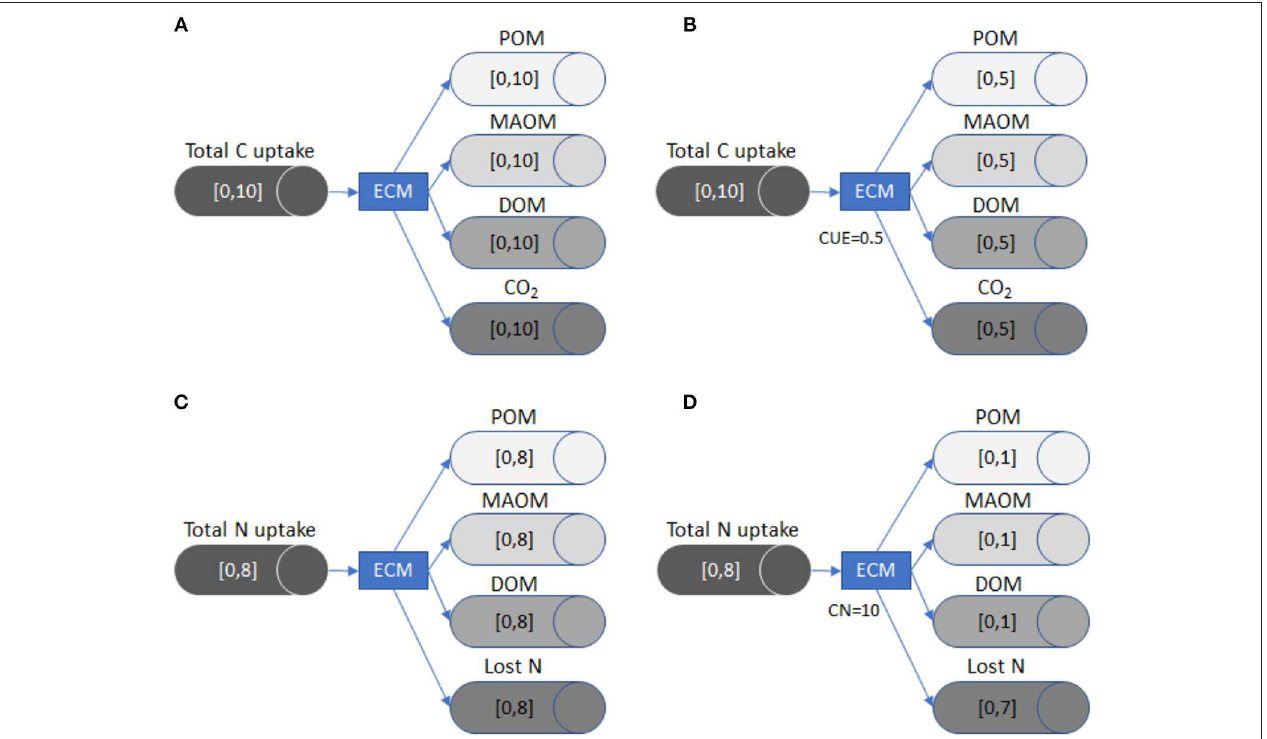
FIGURE 2 | A visual representation of how LSD works using ectomycorrhizal fungi (ECM) as an example. Each tube and arrow represent the C or nutrient transfer to a specific pool (i.e., POM), while the brackets inside each tube define the minimum and maximum flow. The general model (A) shows the possible range of C flows in the absence of stoichiometric or substrate use efficiency constraints. Once the CUE of the fungi is defined in (B) , the maximum flow for CO 2 (respiration) is constrained, which also reduces the potential maximum flow of C for the three remaining pools because the system is at equilibrium and mass balanced. The general model (C) shows the possible range of N flow in the absence of stoichiometric or substrate use efficiency constraints. In (D) , we define the C:N of ECM as 10:1. Because the maximum total C uptake is 10 (A/B), the maximum size of the N flows to POM, MAOM, DOM N pools is reduced to 1. The N flow is constrained due to stoichiometric limitations, since the ECM pool must have ten units of C for every unit of N. The Lost N flow (i.e., transfer to plants) now has a maximum flow size of 7, because the system must remain mass